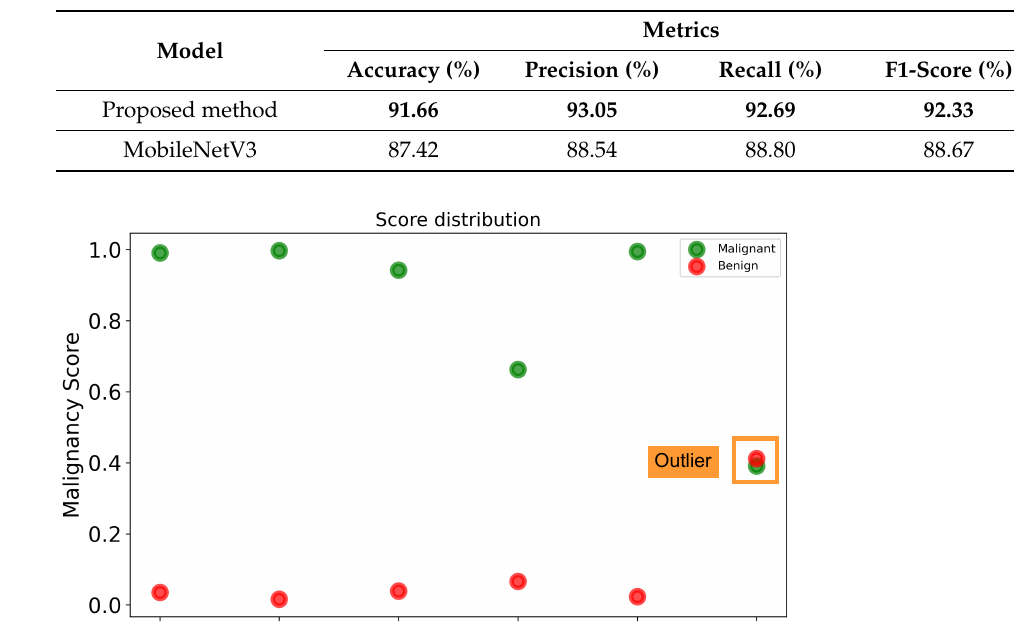
Table 4. Results of the proposed approach based on BUS sequences. The best results are highlighted in bold.